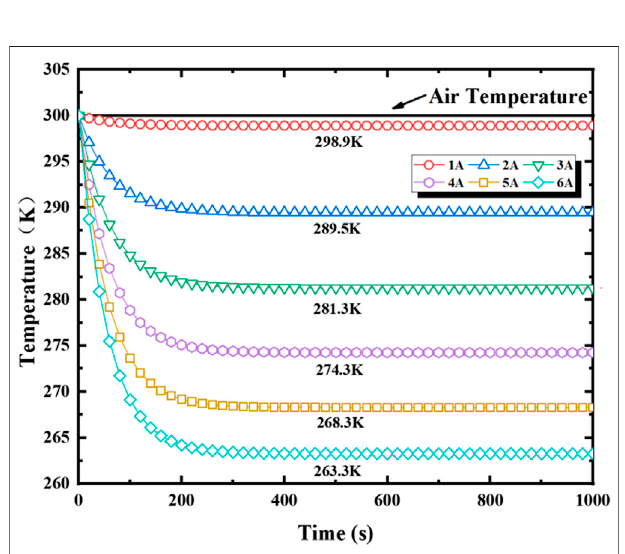
FIGURE 4 | The variation of compartment temperature with time in different